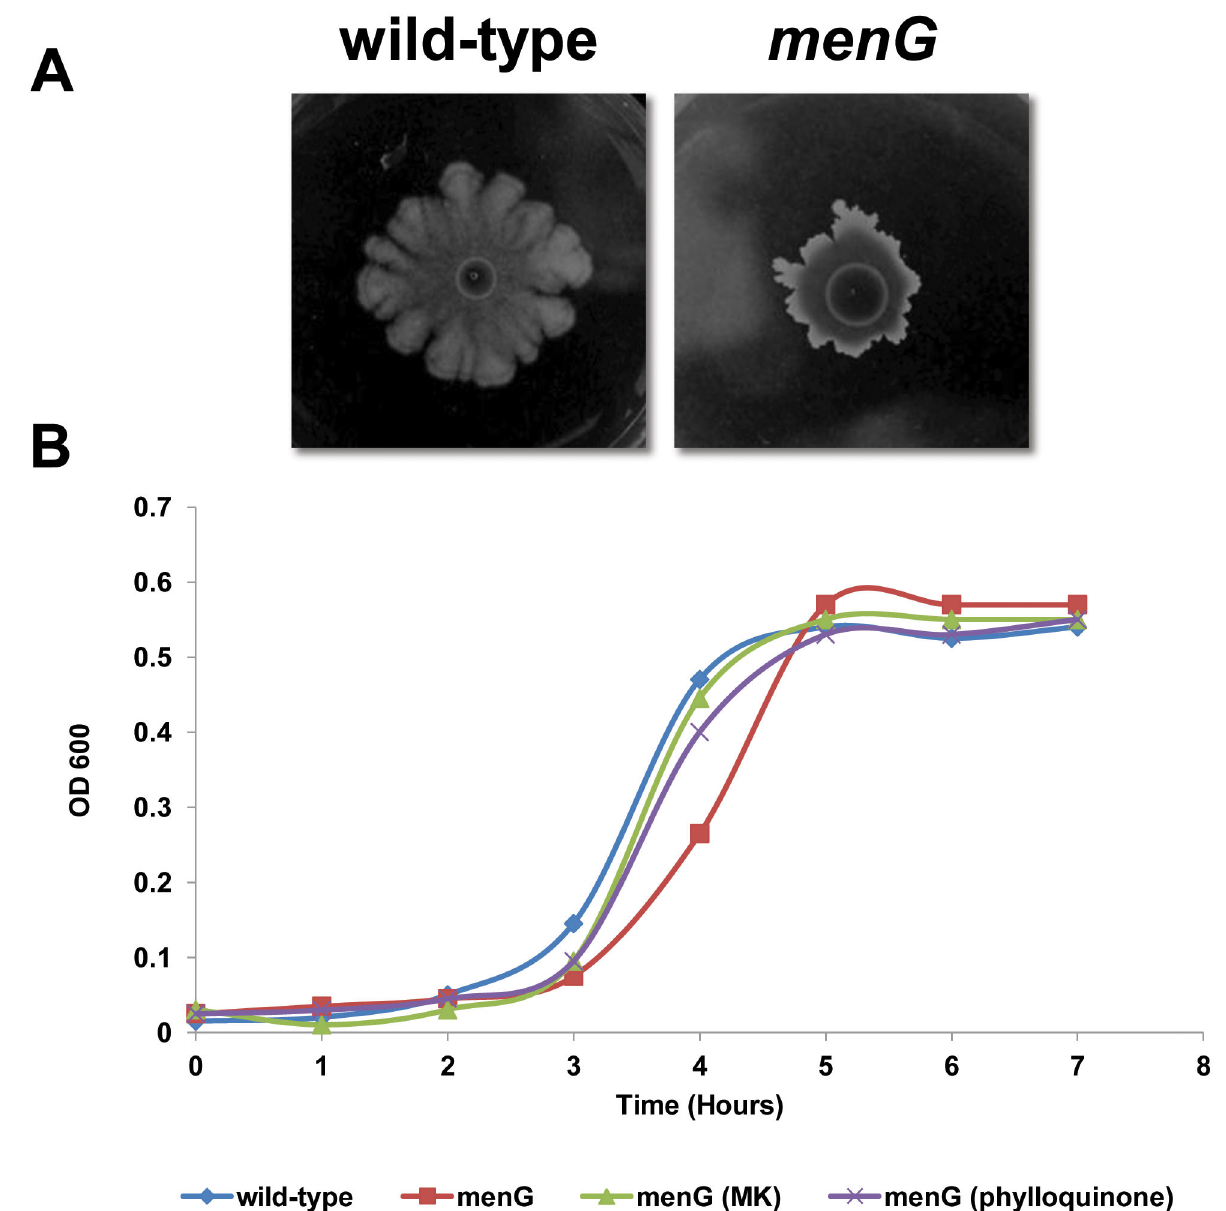
Figure 3. The menG mutant is defective in complex colony development and growth. A . Cells of wild-type (left) and menG (right) strains were spotted on spreading plates containing 1.2% agar and incubated at 37°C in a humid and dark environment. Plates were photographed after 72 hours. The presented results are representative of five independent experiments. B . Growth curves were performed in spreading medium or in spreading medium supplemented with 40 μg/ml of either MK-4 or phylloquinone. The presented results are representative of three independent